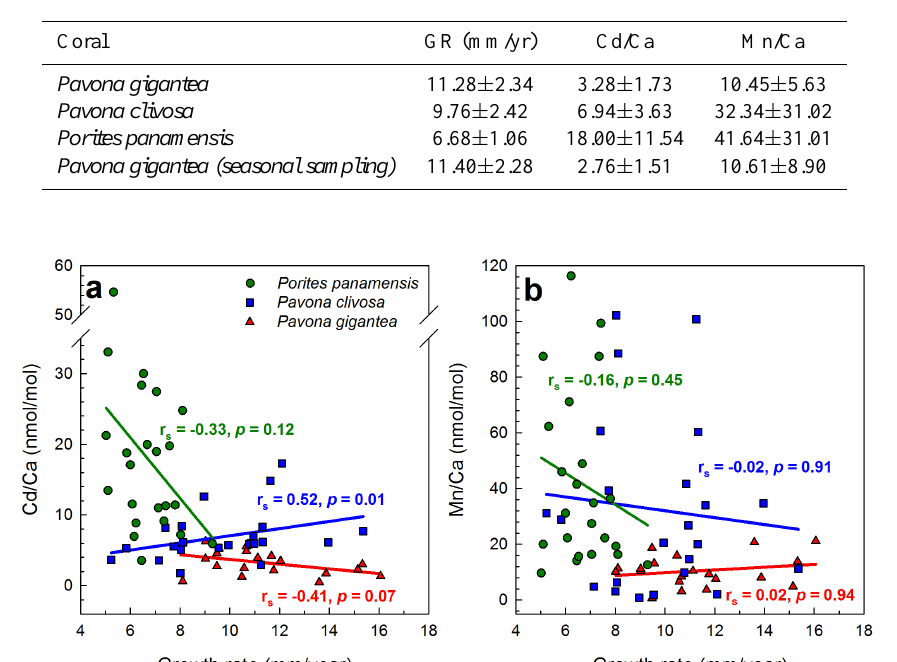
Table 1. Average ( ± 1s.d.) of the growth rate (GR mm/yr) and the Cd/Ca and Mn/Ca ratios (nmol/mol) measured in the corals collected from Cabo Pulmo reef, Gulf of California, Mexico.